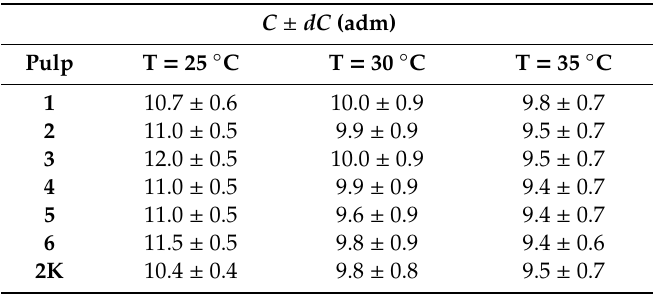
Table 5. Energy parameter C at 25, 30, and 35 ◦